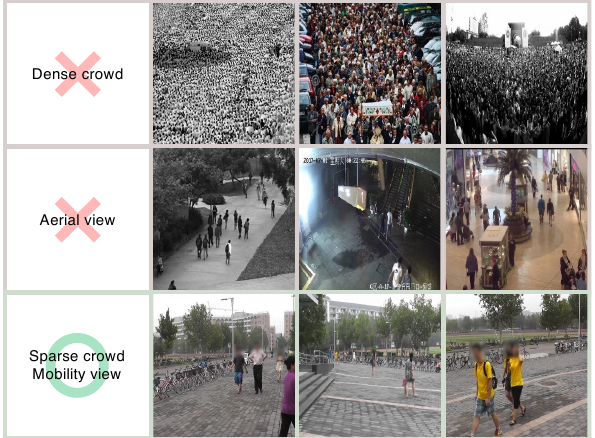
Figure 4. Qualitative analysis of the difference between existing datasets and our target datasets (Person ReID in the